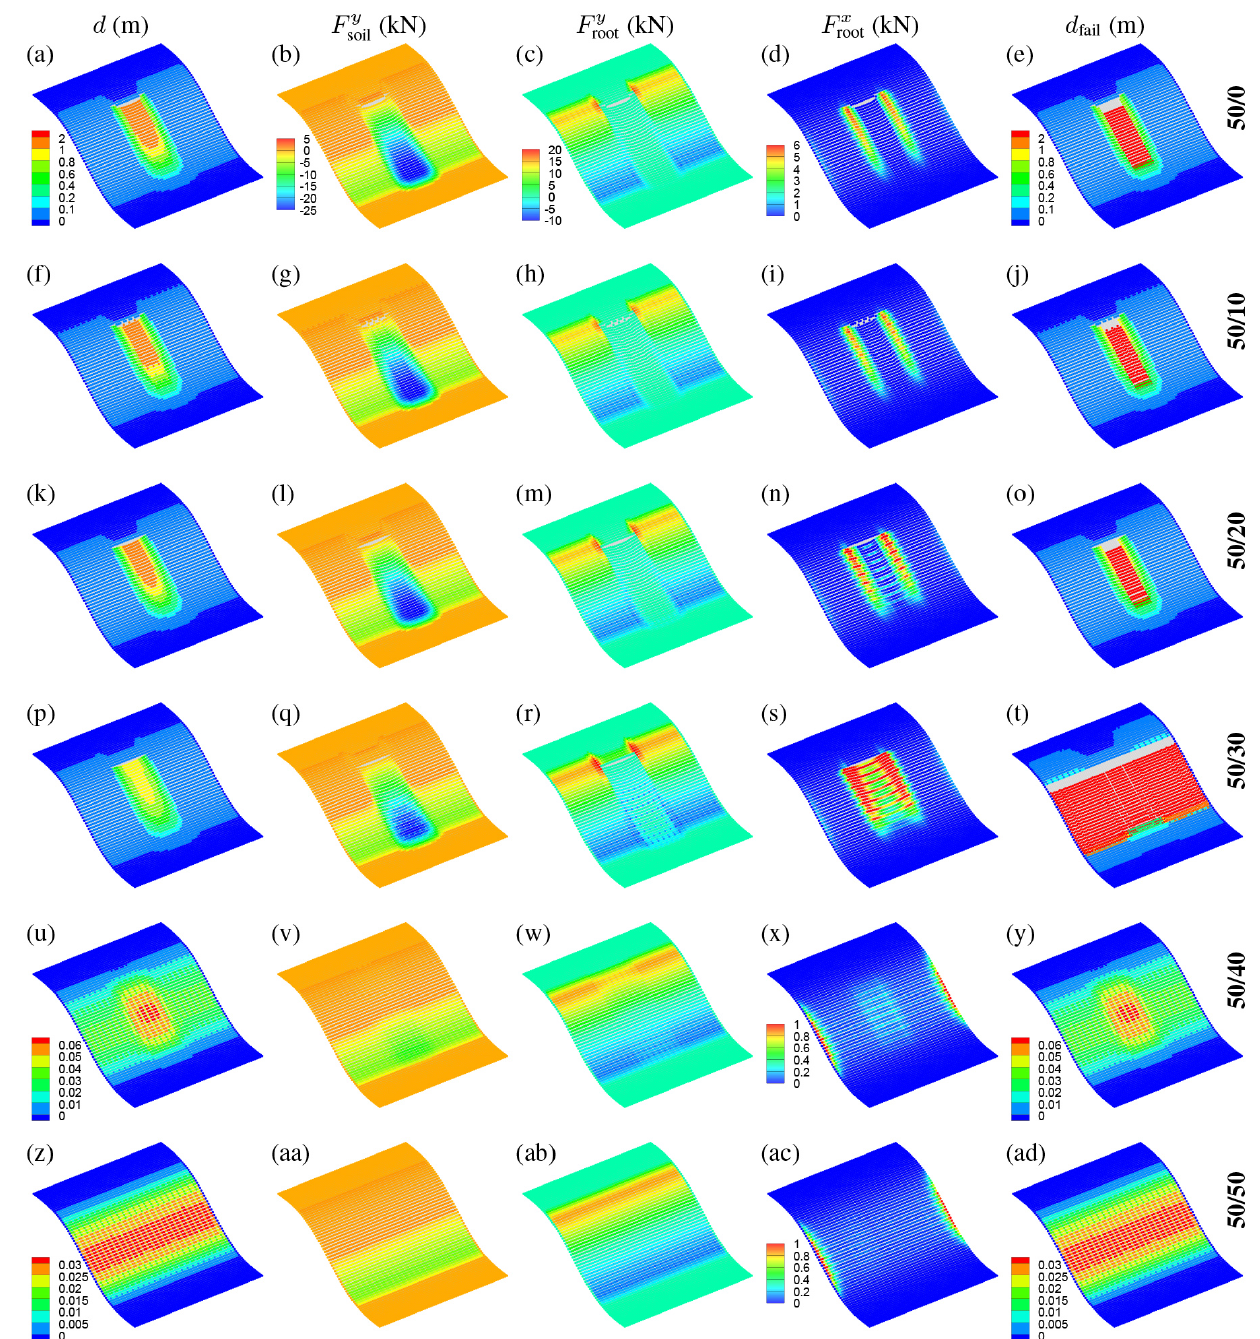
Figure 14. Effect of clearing tree size diameter on slope displacement and soil and root bond forces. From left to right, slope displacement ( d ), soil downslope compression ( F y ), downslope root force ( F y root ), and across-slope root force ( F x root ), at the time step just before failure soil and displacement at failure ( d fail ) for the six simulations with different tree size diameters inside the clearing shown in Fig. 13. (a–e) Empty clearing (50/0), (f–j) DBH = 10cm (50/10), (k–o) DBH = 20cm (50/20), (p–t) DBH = 30cm (50/30), (u–y) DBH = 40cm (50/40), and (z–ad) DBH = 50cm (50/50). Outside the clearing, DBH = 50cm. All trees are spaced 3m apart. Scale is given in the first row except when